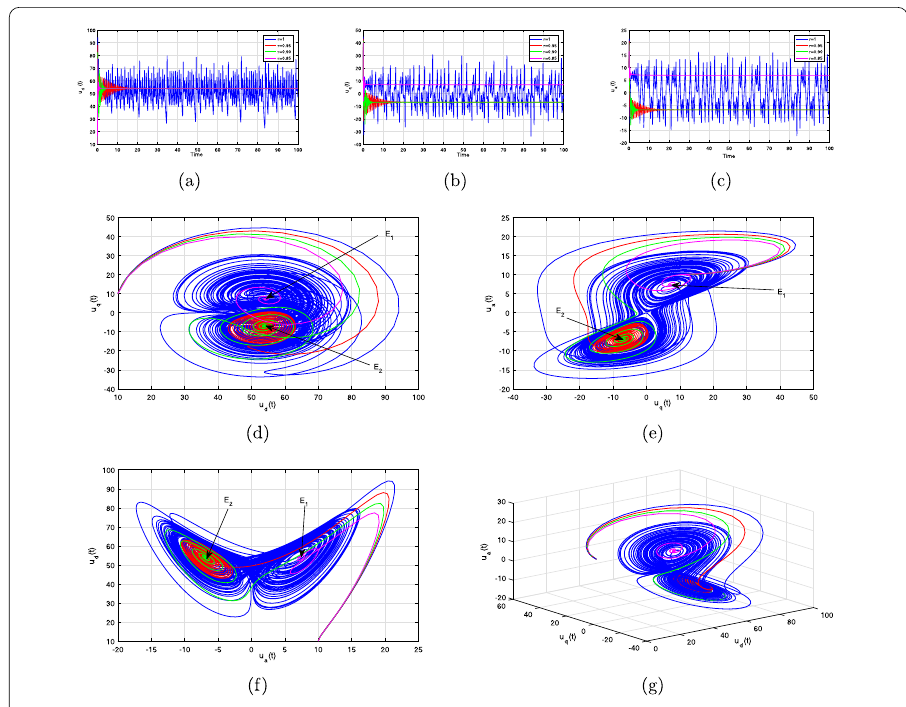
Figure 2 Simulations of Example 1 for time-fractional brushless DC motor (10) in the Liouville–Caputo